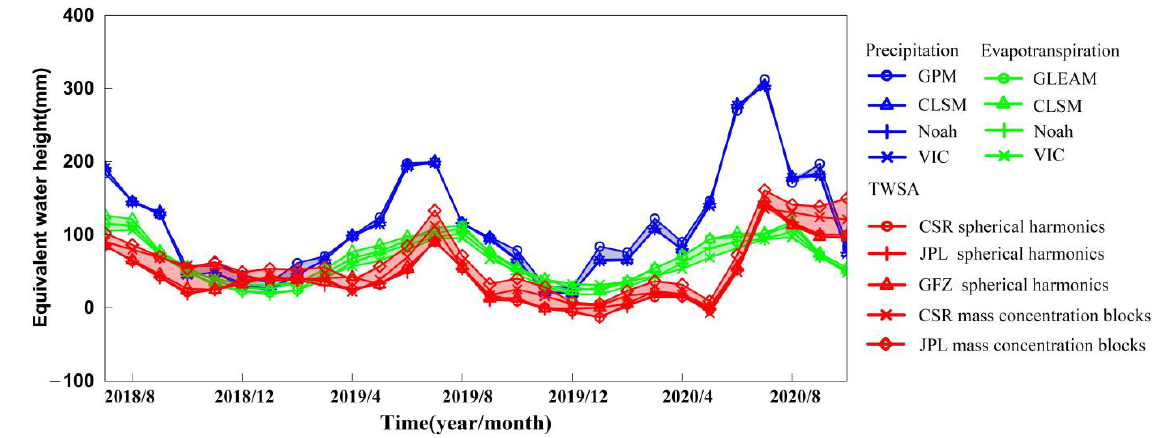
Figure 2. Time series of precipitation, evapotranspiration, and TWSA in the Yangtze River basin between June 2018 and October 2020, on which the shading area with different color represents the change range of different variables.